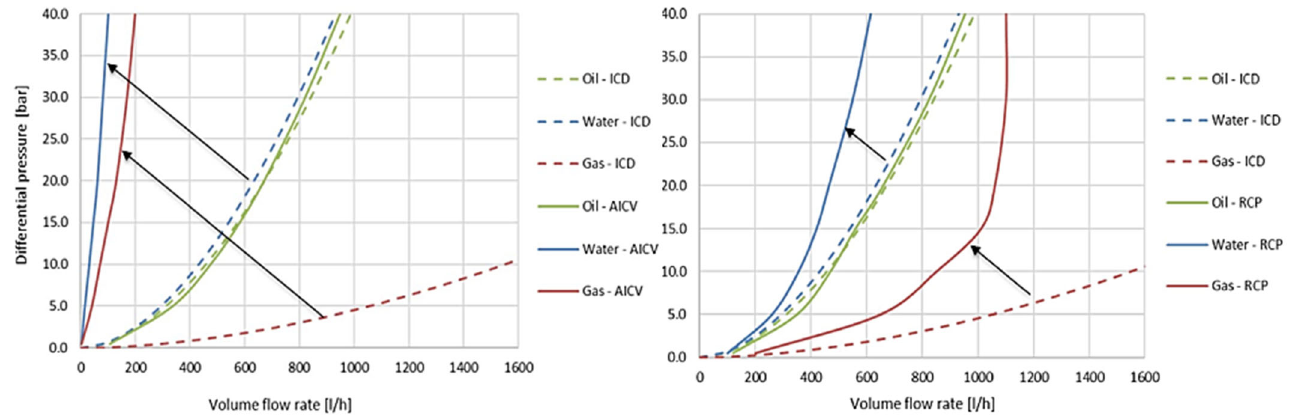
Figure 6. Performance curves of ICDs, AICDs, and AICVs for oil, water, and gas [21].